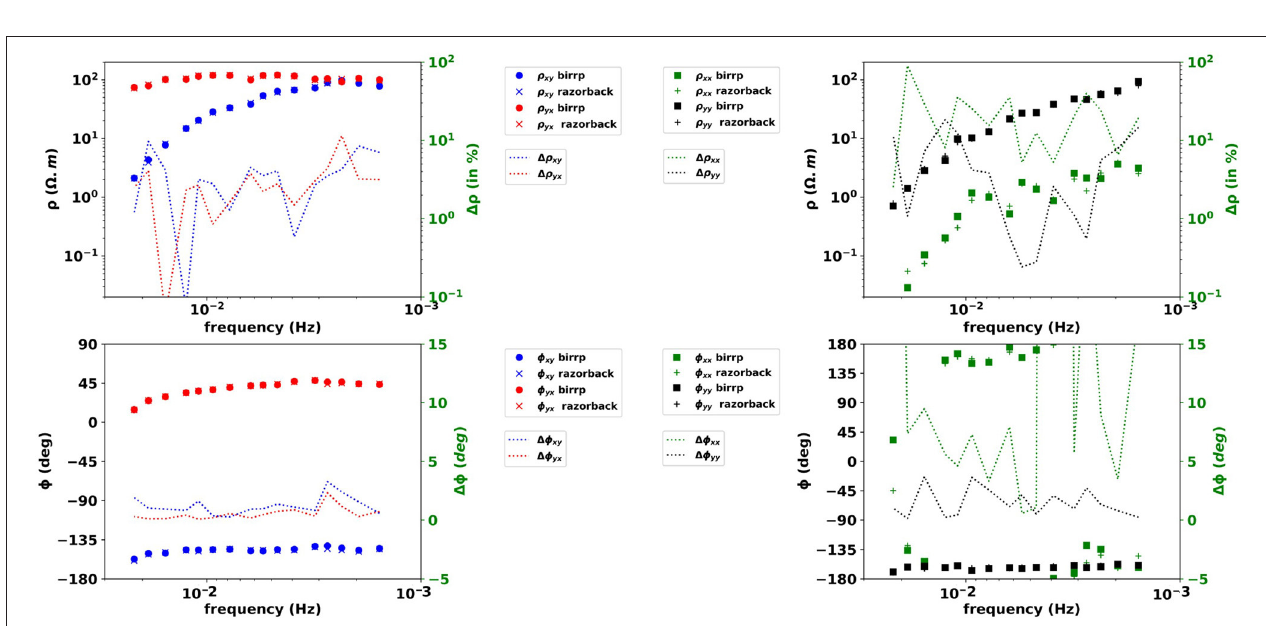
FIGURE 3 | Bounded Influence results in SS configuration. Same legend as Figure 2 but for BI results.